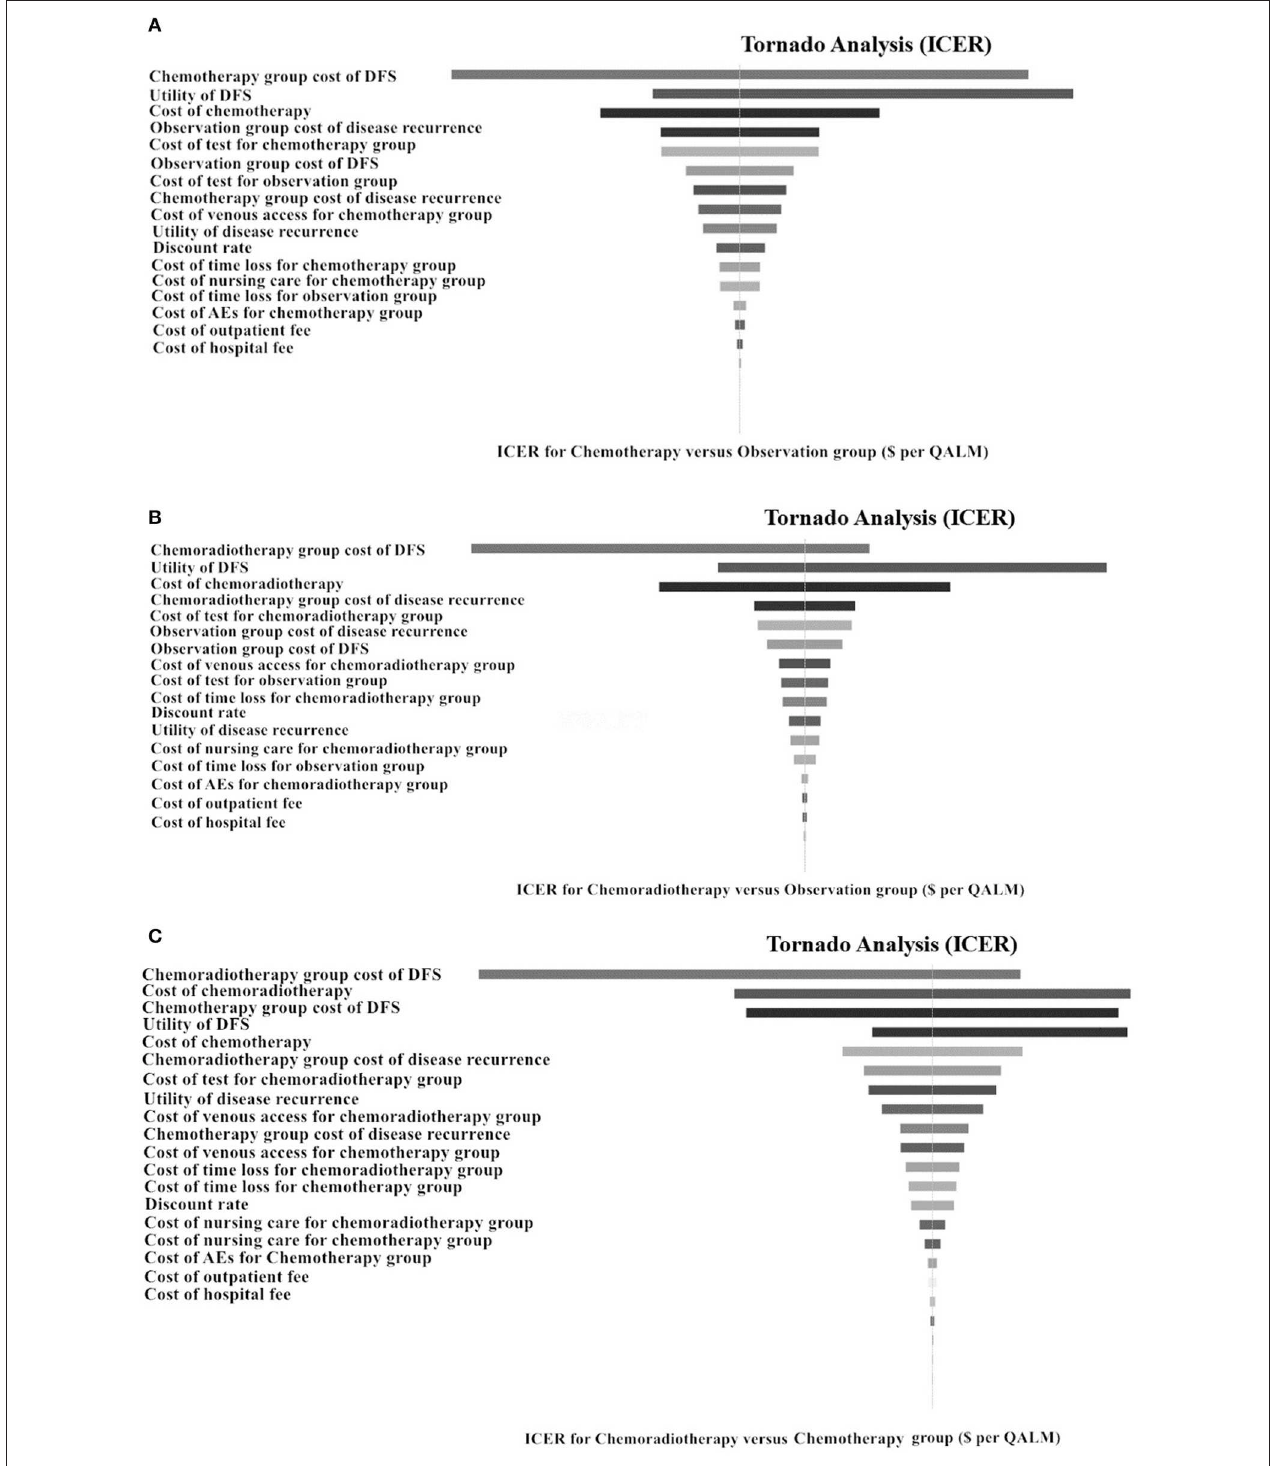
FIGURE 2 | Tornado diagrams of 1-way sensitivity analyses for ICER. Tornado diagrams of univariate analyses for localized gastric cancer after D2-gastrectomy. (A) Adjuvant chemotherapy vs. observation. (B) Adjuvant chemoradiotherapy vs. observation. (C) Adjuvant chemotherapy vs. adjuvant chemoradiotherapy. These diagrams present the results of 1-way analyses of the parameters for 3 different strategies. The width of the bars represents the range of results of our analysis when the parameters are changed. p, transition probability; DFS, disease-free survival; QALM, quality-adjusted life month (quality-adjusted life year/12); ICER, incremental cost-effectiveness